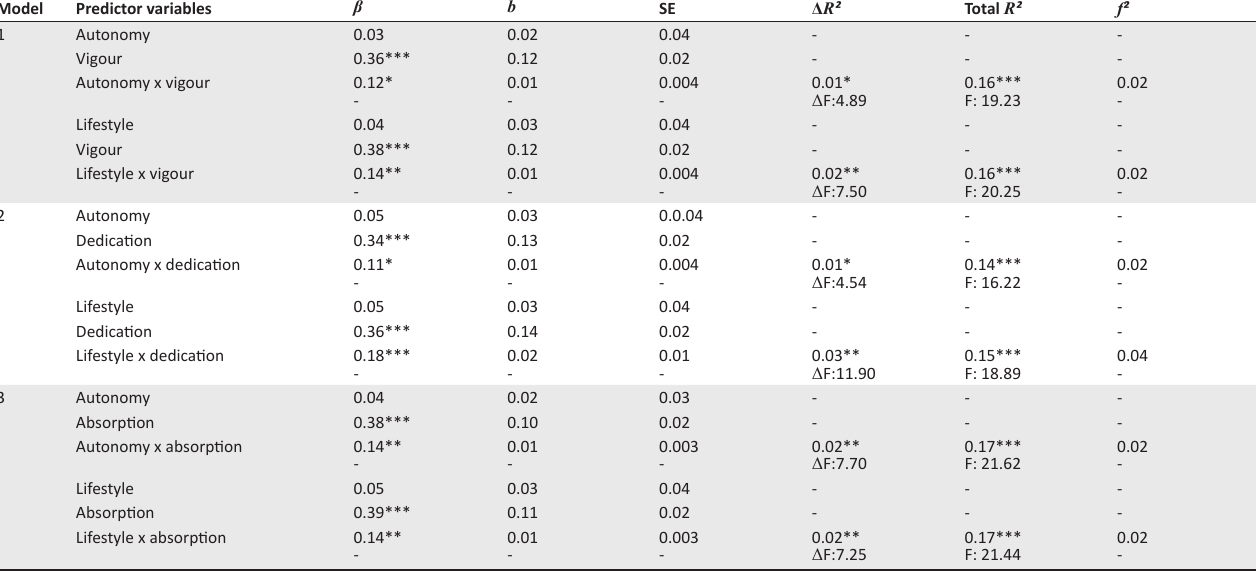
TABLE 4: Moderated regression analysis examining the interaction effects between the autonomy and lifestyle career anchors and vigour, dedication and absorption (work engagement) on job commitment. Model